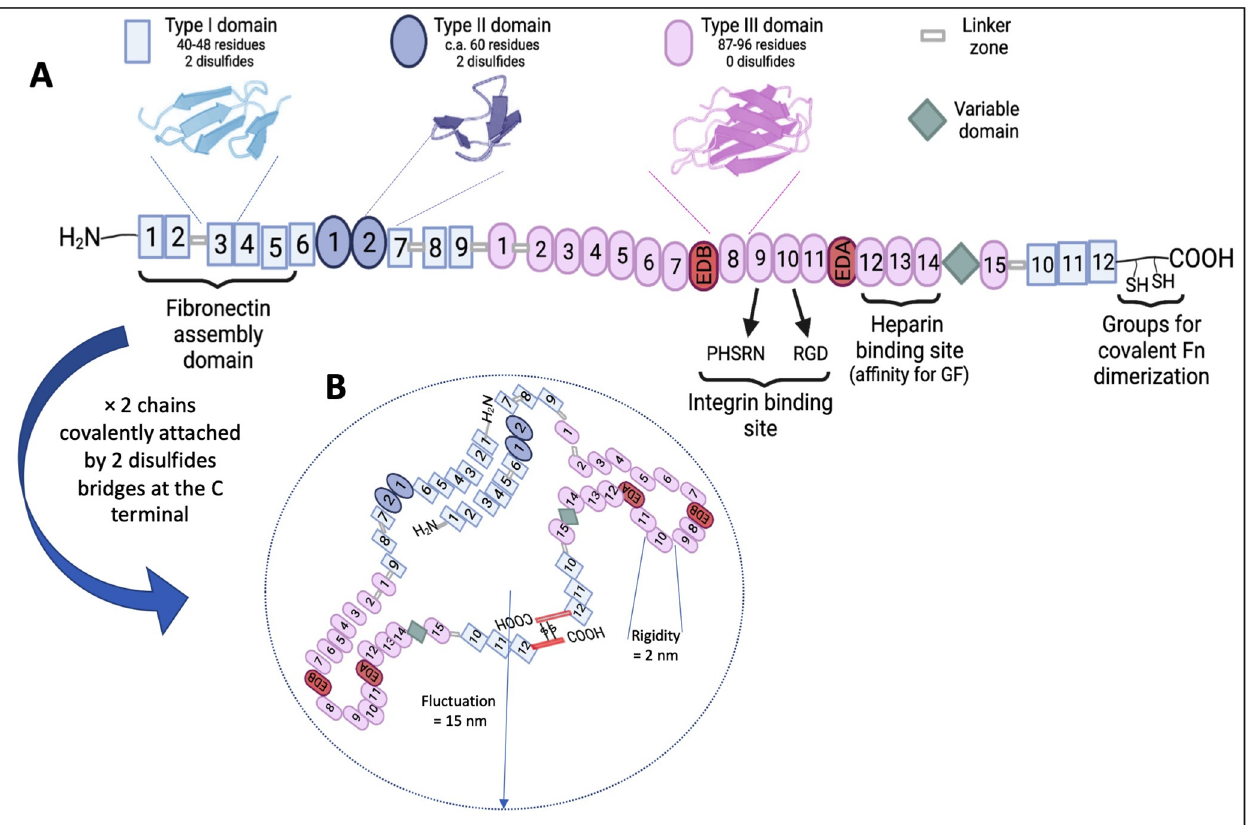
Figure 1. ( A ) Schematic representation of the modular composition of a fibronectin (Fn) chain. Type I, II, and III domains are depicted in light blue, purple, and pink, respectively. Upper: representative molecular model view of the β –sheet’s secondary structural elements involved in the three different domains. The variable domain and extra domains A (EDA) and B (EDB) are indicated in green and red, respectively. Above: from left to the right, the brackets show the Fn assembly domain at the N–terminus, the integrin- and heparin–binding site in the central cell–binding domain, and sulfhydryl groups for covalent Fn dimerization at the C-terminus. ( B ) Representative view of the volume occupied by the dimeric soluble compact Fn in a solution.